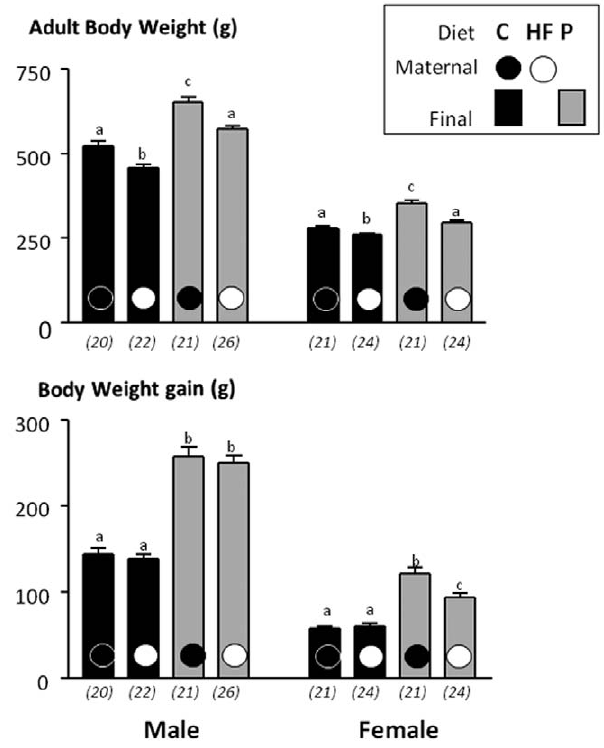
Figure 6. Impact of post weaning diet on the body weight of male and female pups born to dams fed the control diet (C) or high-fat diet (HF). At weaning offspring were divided into four groups of each gender (CC, CH, PC, PH; n from 20 to 26) and named according to the post weaning diet (C or P, first letter) and to maternal diet (C or H, second letter). From weaning to 7 weeks of age all groups were assigned to chow diet then swithched to C or P diet for 13 additional weeks. Body weight and body weight gain are reported in panel A and B, respectively. Different superscript letters a,b,c denote significant differences at p , 0.05 by ANOVA and the Fisher posthoc